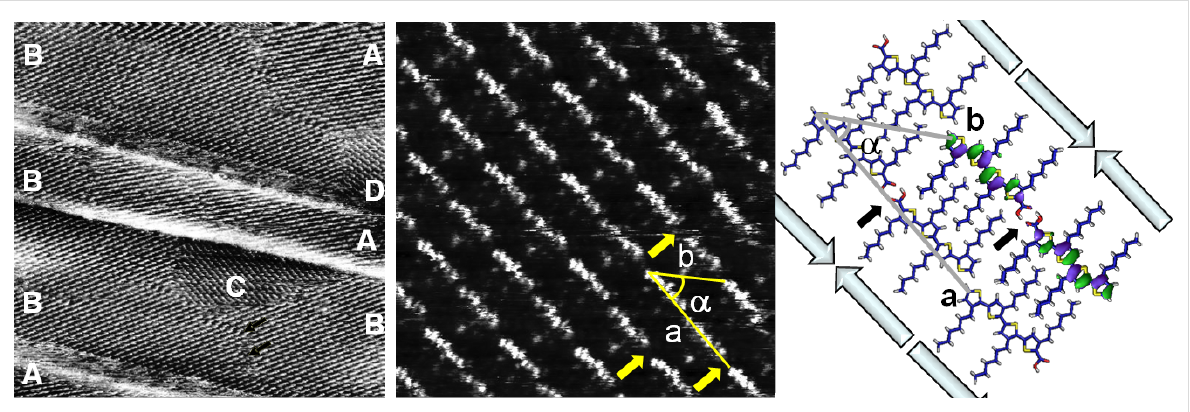
Figure 2: Left: STM image of H4TCOOH on HOPG (100 × 100 nm 2 , U = − 120 mV, I = 50 pA). The letters label the different domains as explained in the text. Center: STM current image of H4TCOOH on HOPG (10 × 10 nm 2 , U = − 100 mV, I = 50 pA). The arrows label the positions of the carboxylic groups. Right: Quantum chemical model of the adsorbate, including the electron-density distribution of the HOMO and HOMO − 1 for the dimer.